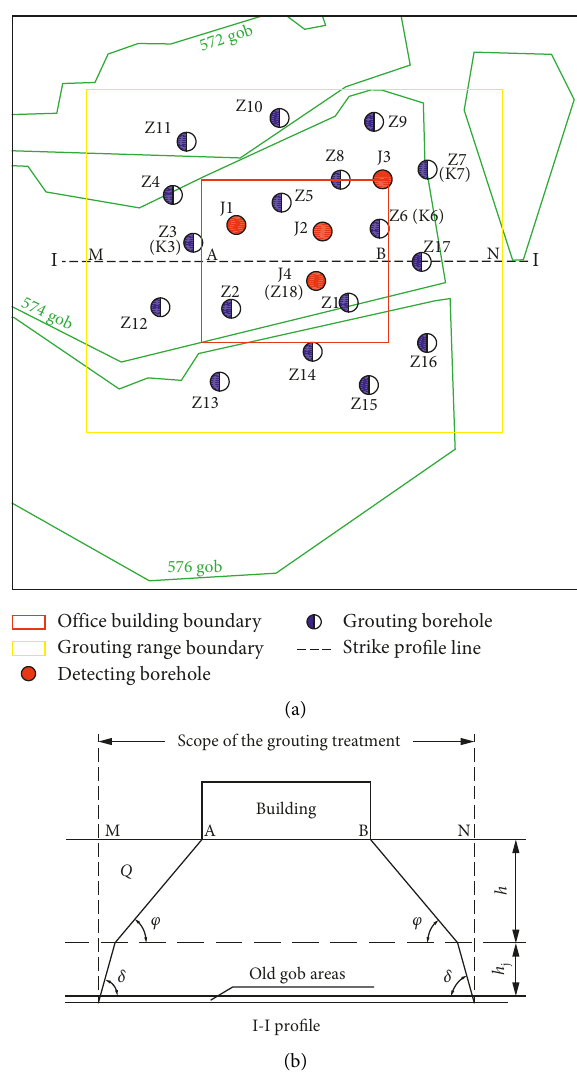
Figure 8: (a) Grouting scope design and grouting boreholes ar- rangement; (b) grouting scope of the I-I profile. φ , movement angle of Quaternary strata; δ , strike movement angle of bedrock; Q , Quaternary strata; h , thickness of Quaternary strata; h j , thickness of